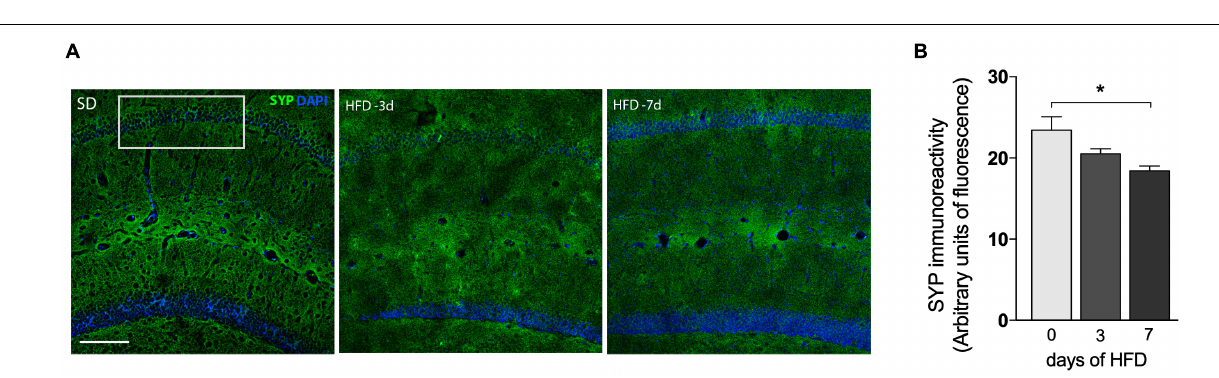
FIGURE 4 | Decrease of synaptic density after 7 days of HFD. (A) Immunofluorescence analysis for the expression and localization of the pre-synaptic terminals immunolabeled for pre-synaptic marker synaptophysin (SYP) in hippocampal CA1 region of mice submitted to SD (0), 3 or 7 days of HFD ( n = 4–5, one-way ANOVA followed by Dunnett post hoc test). SYP represented in green and DAPI represented in blue. Scale bar = 50 µ m (B) quantitative analysis for the SYP immunoreactivity. Data are shown as mean ± SEM. * p < 0.05 SD vs.